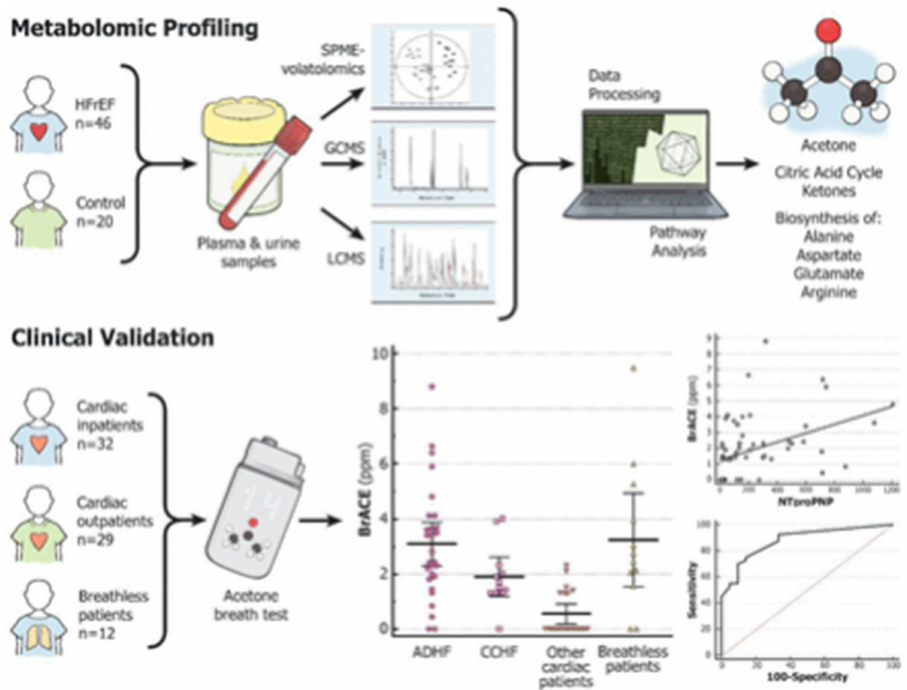
Figure A1. HFrEF = heart failure reduced ejection fraction, CCHF = chronic compensated heart failure, SPME = Solid-phase microextraction, GCMS = Gas chromatography mass spectrometry, LCMS = Liquid chromatography mass